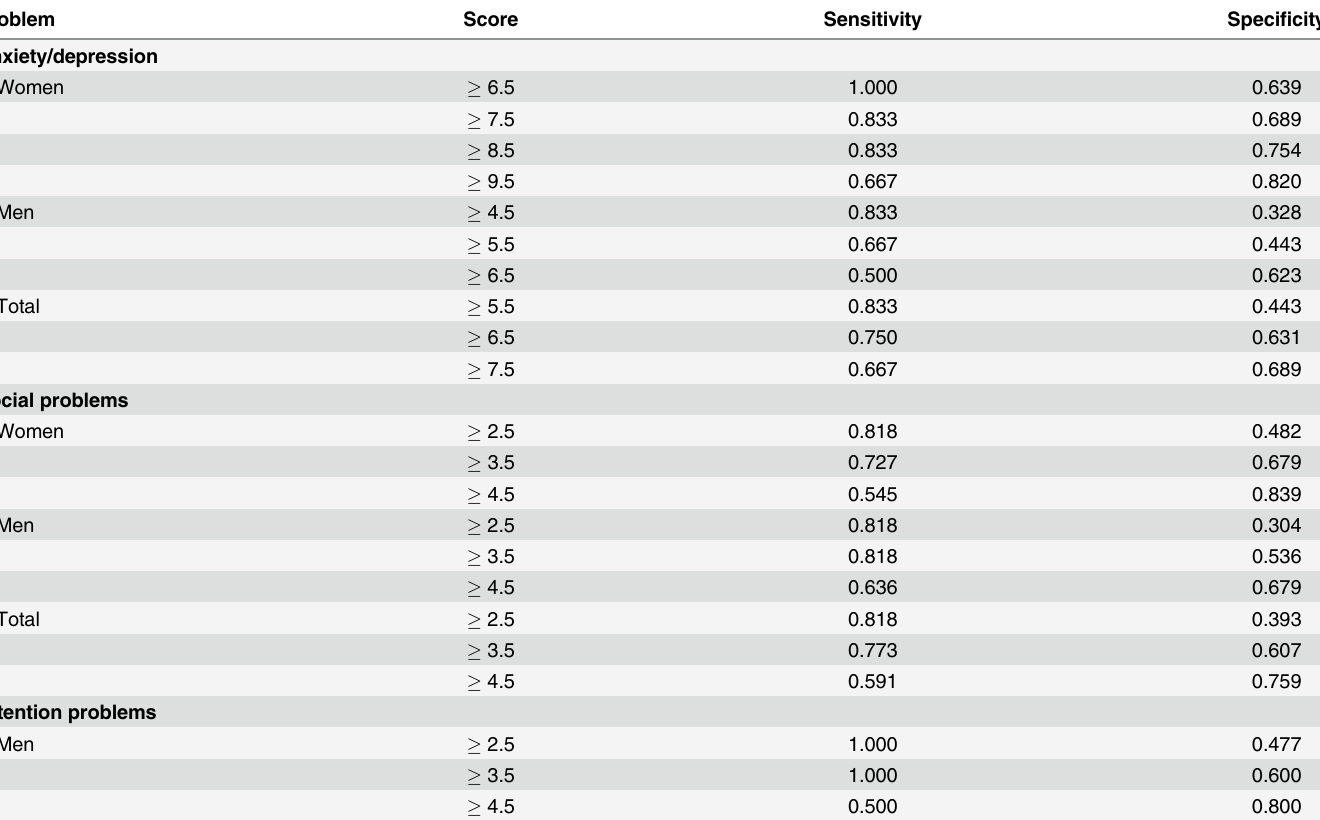
Table 5. Sensitivity and specificity for diagnosis of anxious/depression problems, social problems, and attention and rule-breaking problems. Problem Score Sensitivity Speci fi